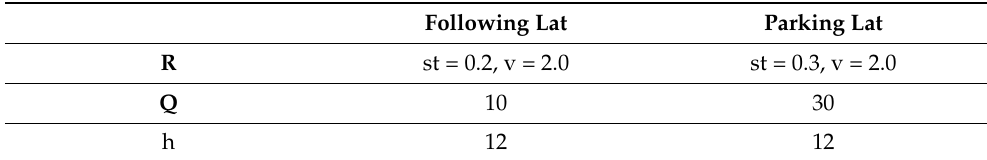
Table 3. MPC controllers’ parameters. st: steering weight, v: velocity weight (adimensional), h: prediction horizon (control steps).